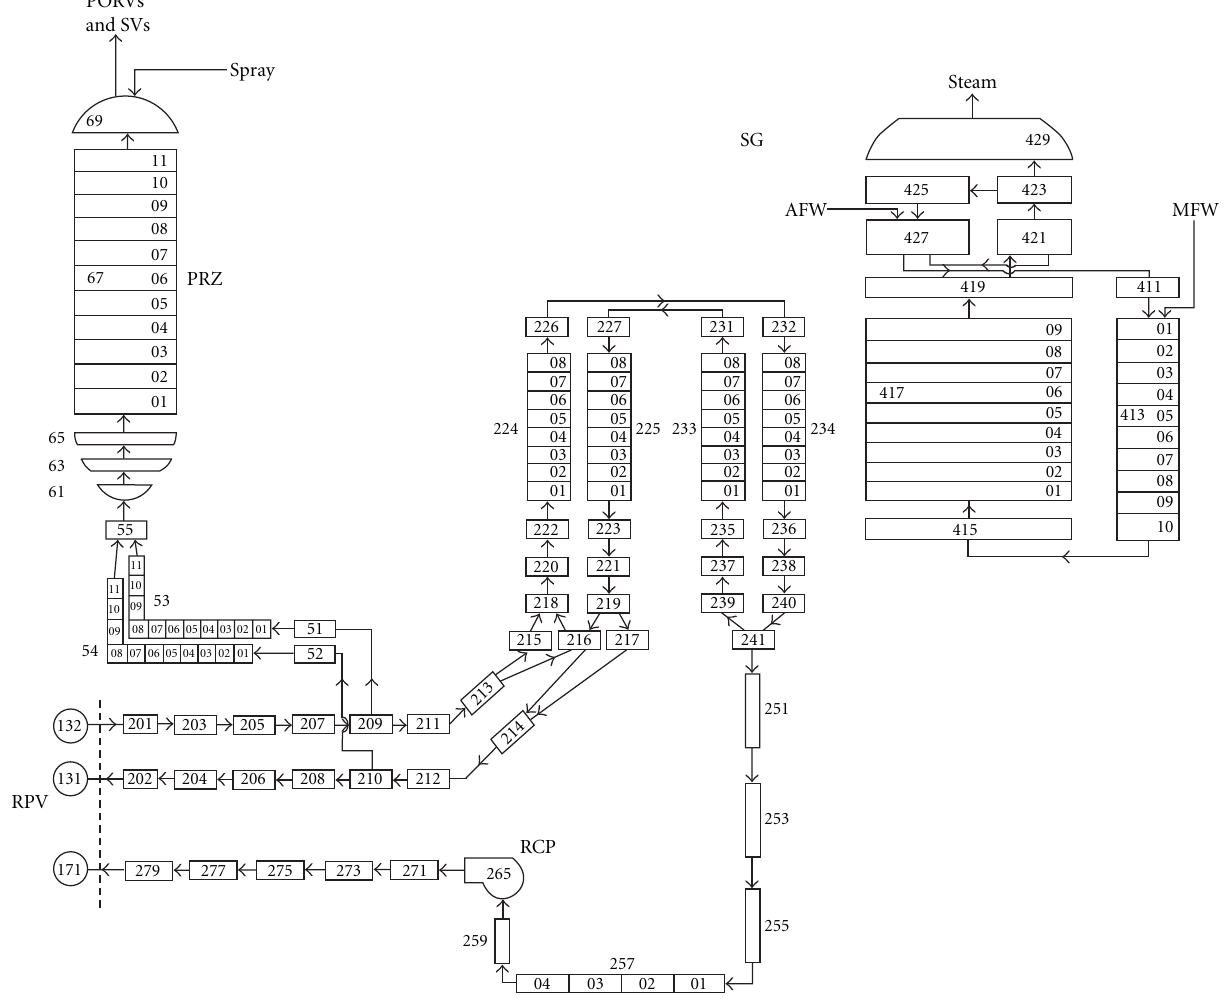
Figure 3: RELAP5/SCDAPSIM nodalization for modelling natural circulation.